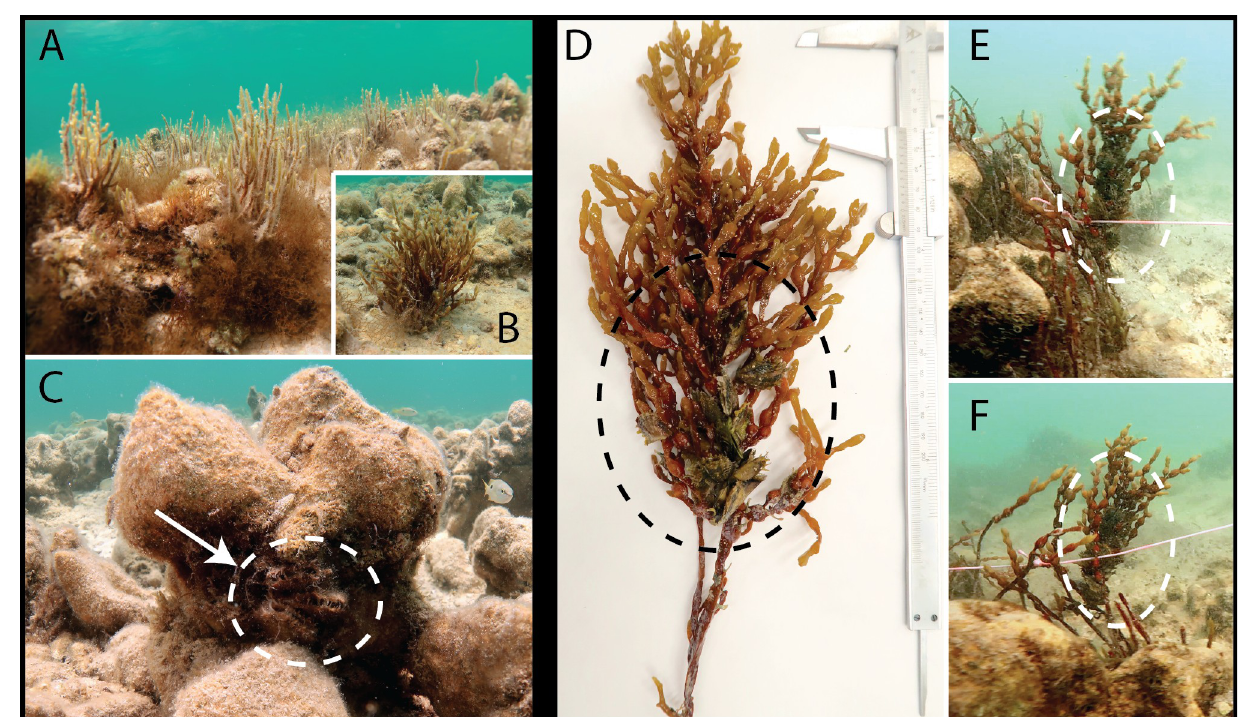
Fig 2. In-situ imagery of two locomotive phases observed at a fixed site in Um-Bab, Qatar. First phase (A-C) specimens remain clumped and attached by byssal threads within rock crevices. Second phase (D-F) with the majority of specimens relocated to the fronds of red algae.